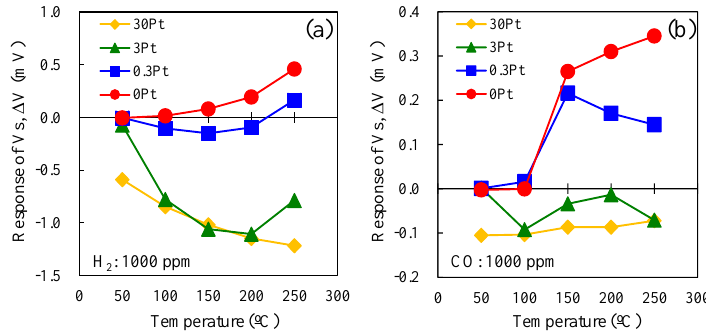
Figure 11. The ΔV of the single and double catalyst structure micro-TGS with AuPtPd/SnO 2 and 0.3–30 wt% Pt/α-Al 2 O 3 catalyst at 200 °C for ( a ) 1000 ppm H 2 , and ( b ) 1000 ppm CO in dry air.